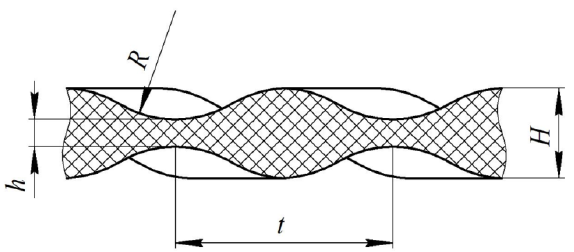
Figure 3. Characteristic dimensions of the area formed by chevron heat exchange plates.